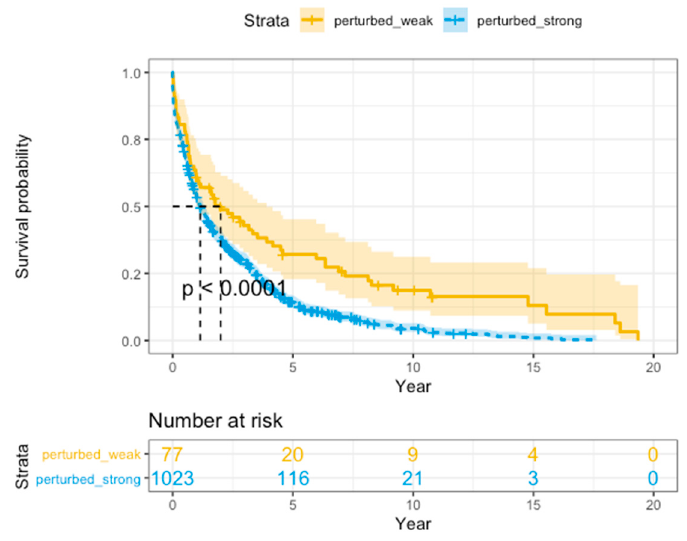
Figure 5. Kaplan–Meier survival analysis. The survival curves of the perturbed-weak and perturbed-strong groups of BRCA based on the iPS in the DAP12 interaction pathway. The X axis is survival in days. The Y axis is the overall survival rate.